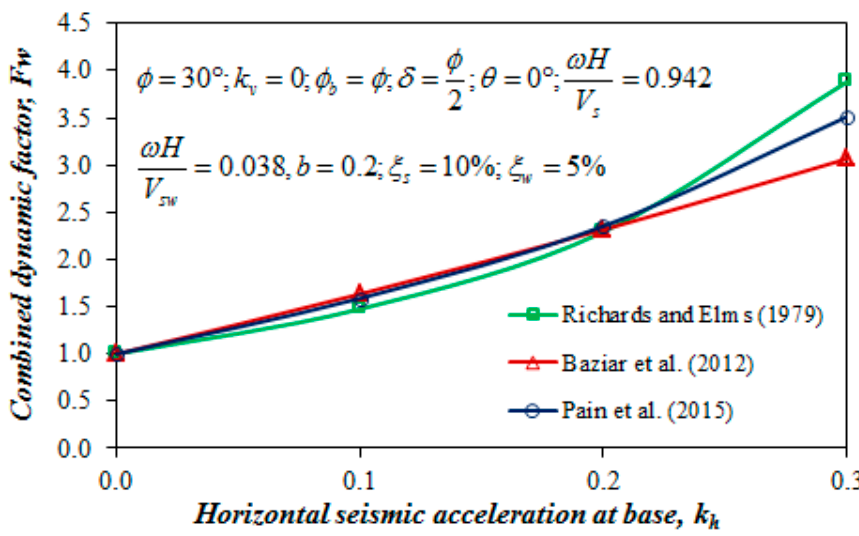
Figure 4. Comparison of results for k v = 0.5k h , φ = 30 0 , δ = φ /2, H/ λ = 0.942, H/ η = 0.038.